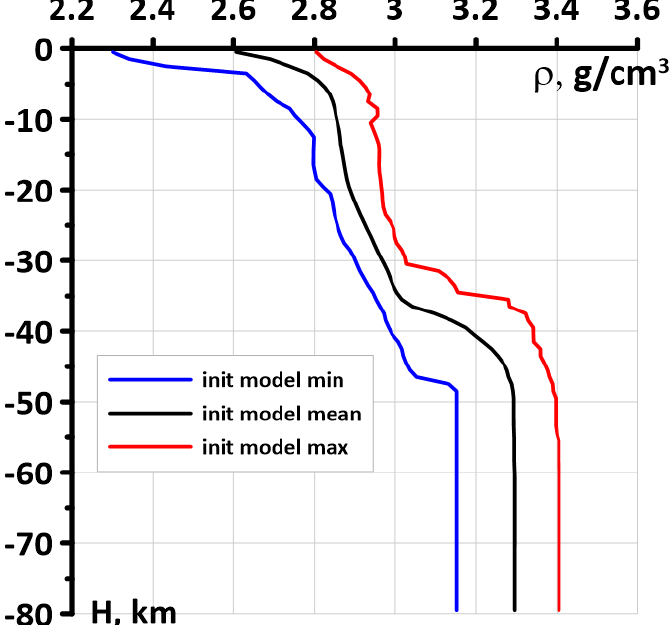
Figure 3. Initial dependency of average density value versus depth ρ 0 ( z ) (black line). Minimum (blue line) and maximum (red line) density values on corresponding depth levels are also shown.